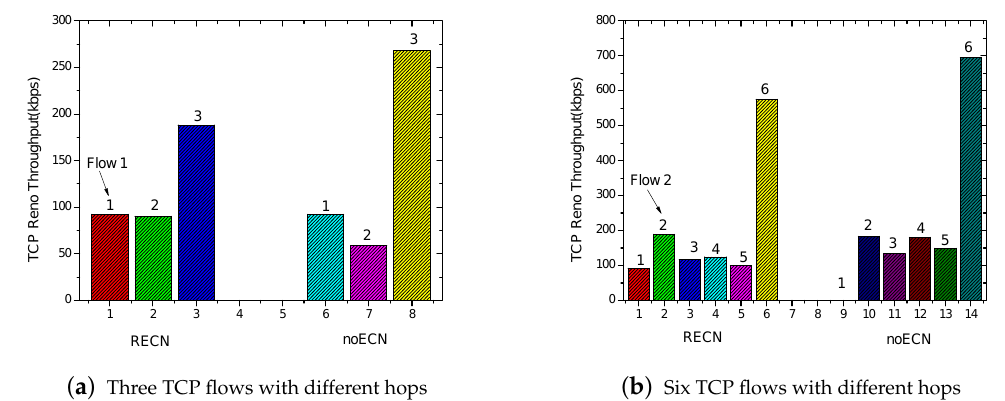
Figure 9. Comparison of fairness with different